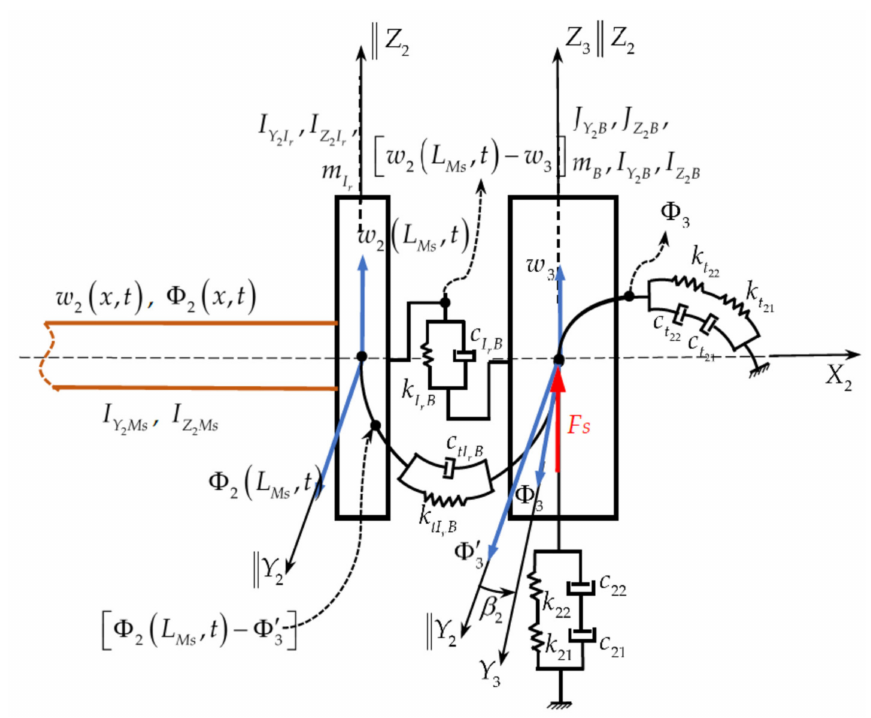
Figure 7. Bowl-inner race joint part of DMFFBV: bowl, bowl-inner race joint, and